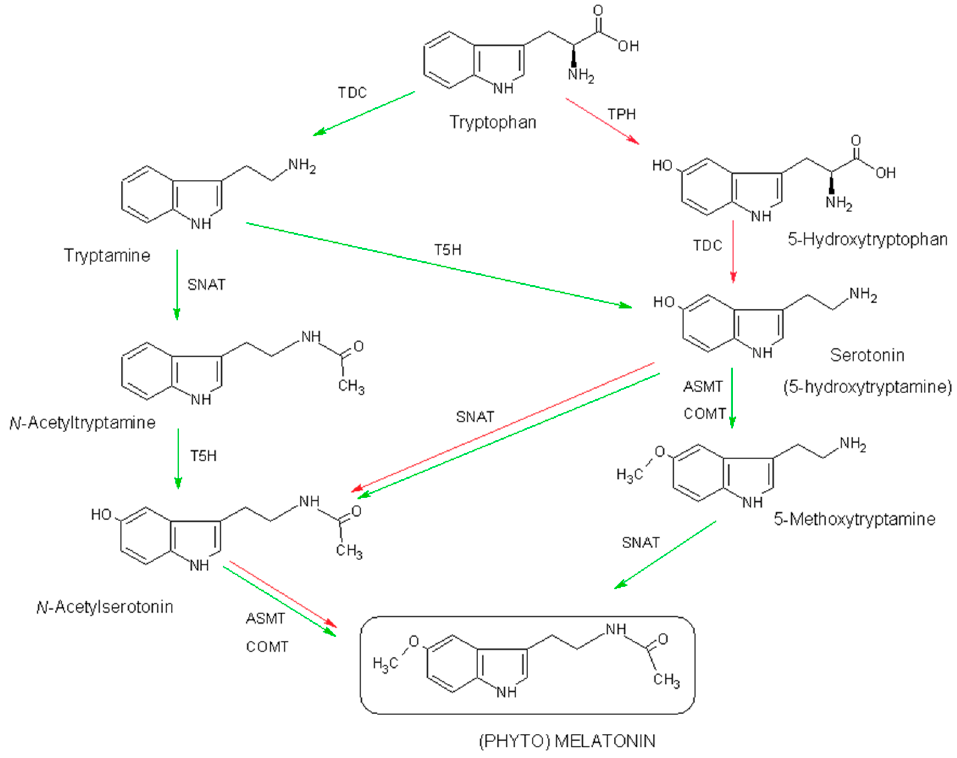
Figure 1. Biosynthetic pathways of phytomelatonin. The enzymes of the respective steps are: T5H—tryptophan 5-hydroxylase; TDC—tryptophan decarboxylase; TPH—tryptophan hydroxylase; SNAT—serotonin N -acetyltransferase; ASMT—acetylserotonin methyltransferase, and COMT—caffeic acid O -methyltransferase. The green and red lines show the predominant pathway in plants and in animals, respectively.